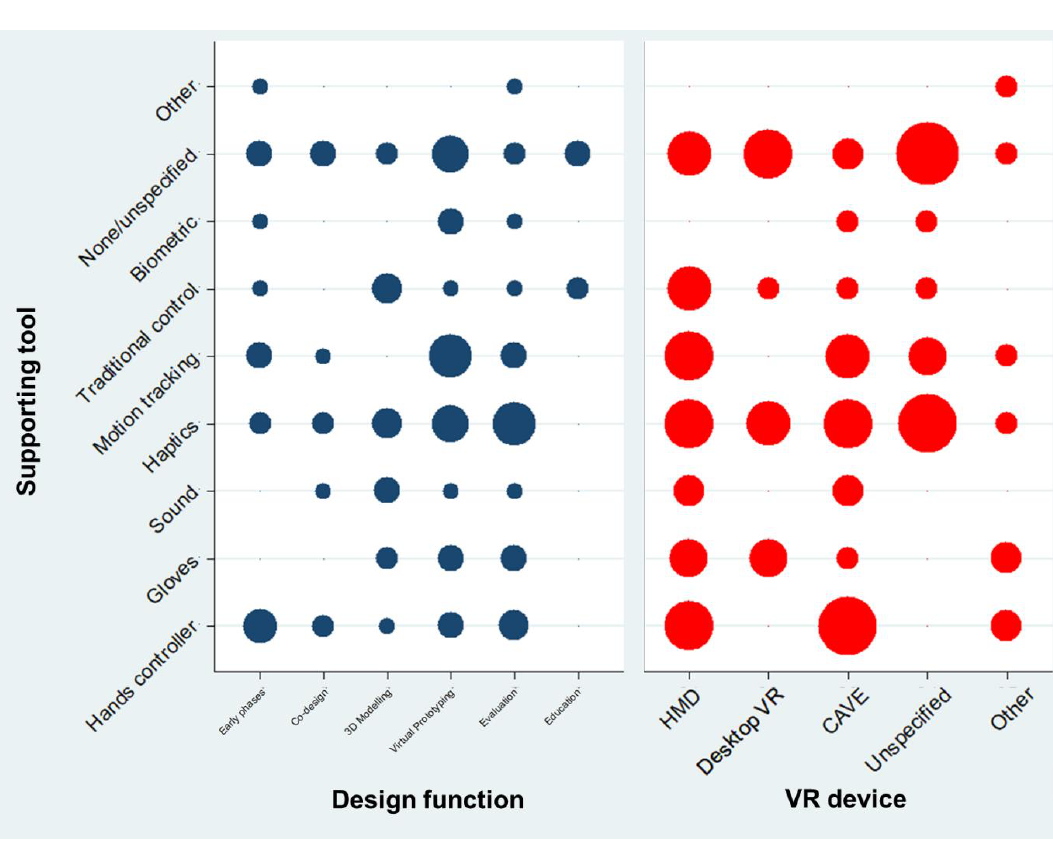
Figure 7. Use of supporting tools in VR applications in design and their distribution against design functions and reference VR technologies.